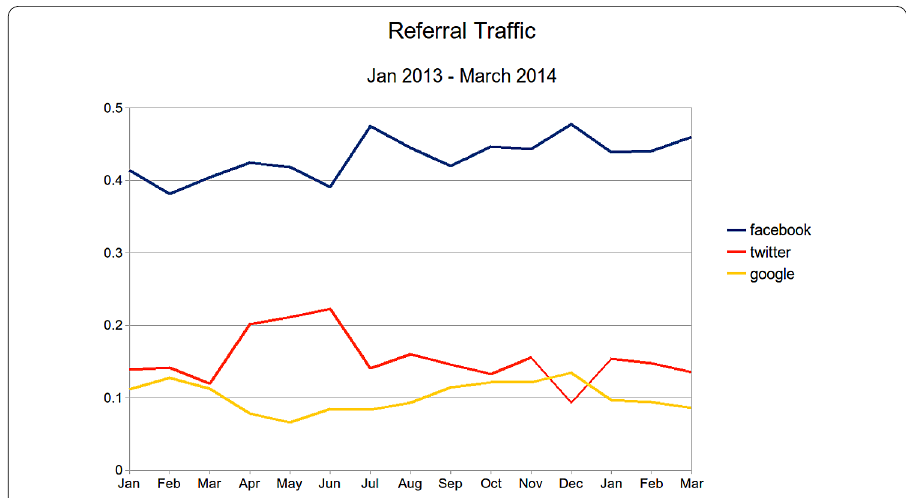
Figure 8 The percentage of all traffic to the UK petitioning website through referral from different channels. A robust share of the traffic to the site is referred from Facebook and